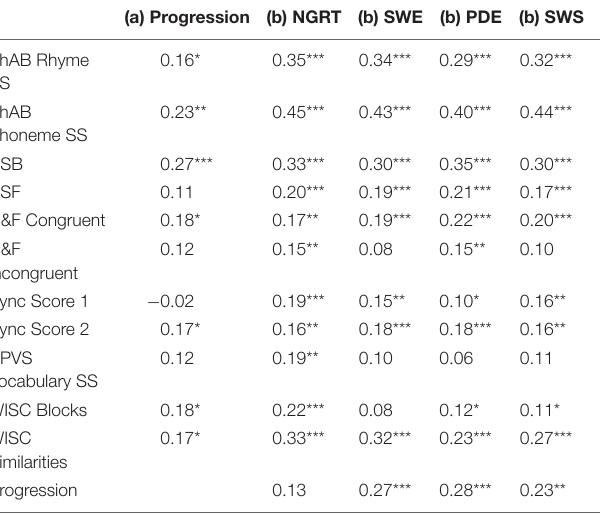
TABLE 2 | Time-lagged Spearman’s correlations between the neurocognitive predictors measured prior to intervention and (a) the progression measure for GG Rime children ( N = 195), and (b) the post-intervention literacy measures ( N =